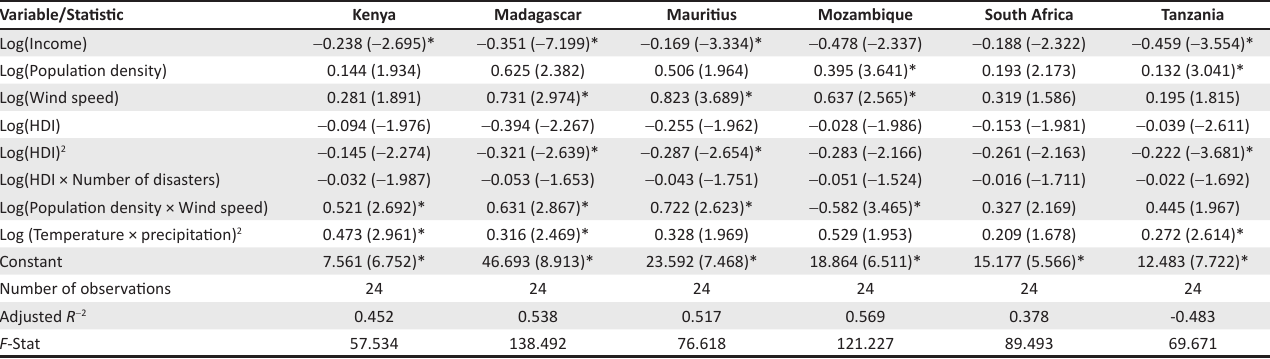
TABLE 2: Estimates of historical damage functions.